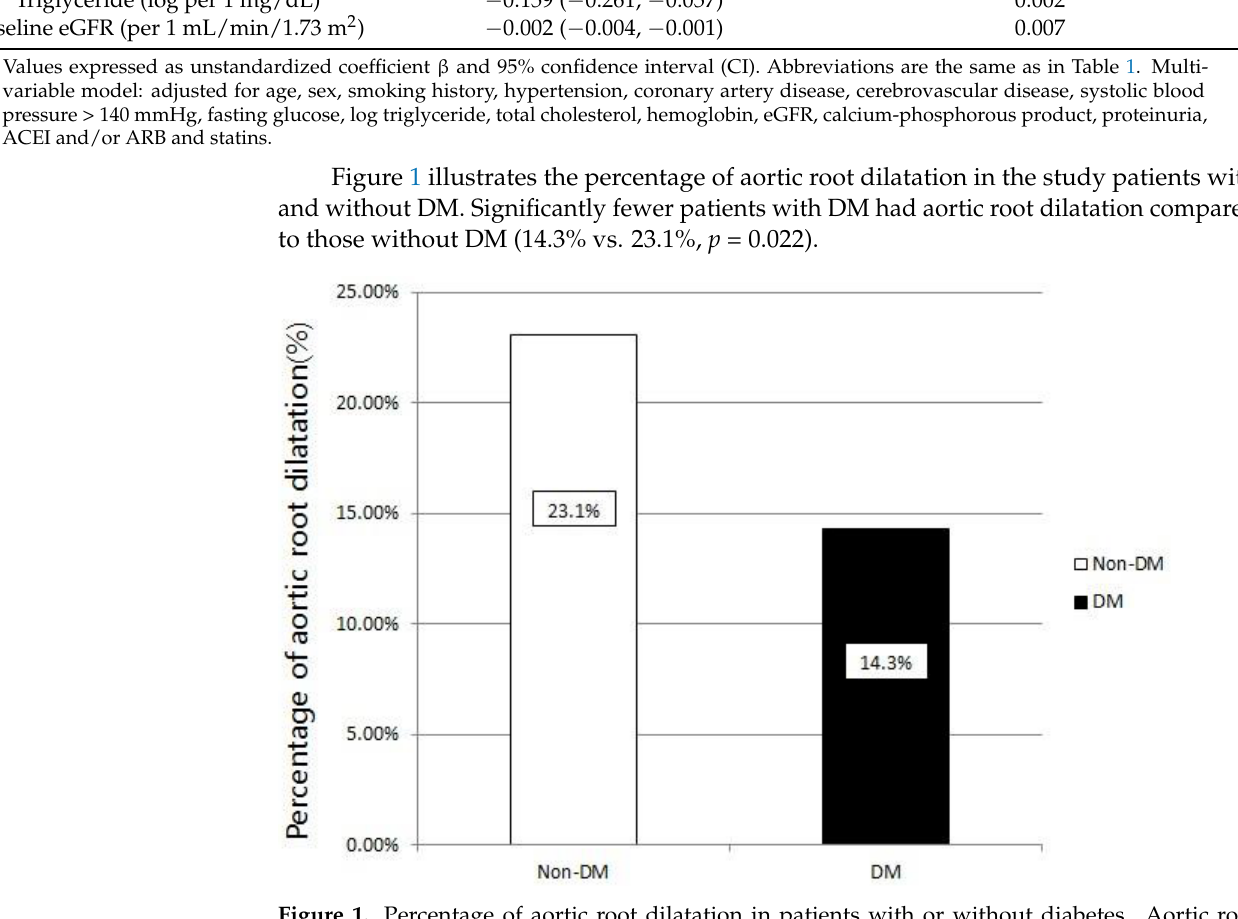
Table 3. Determinants of ARD/BSA using multivariable stepwise linear analysis.